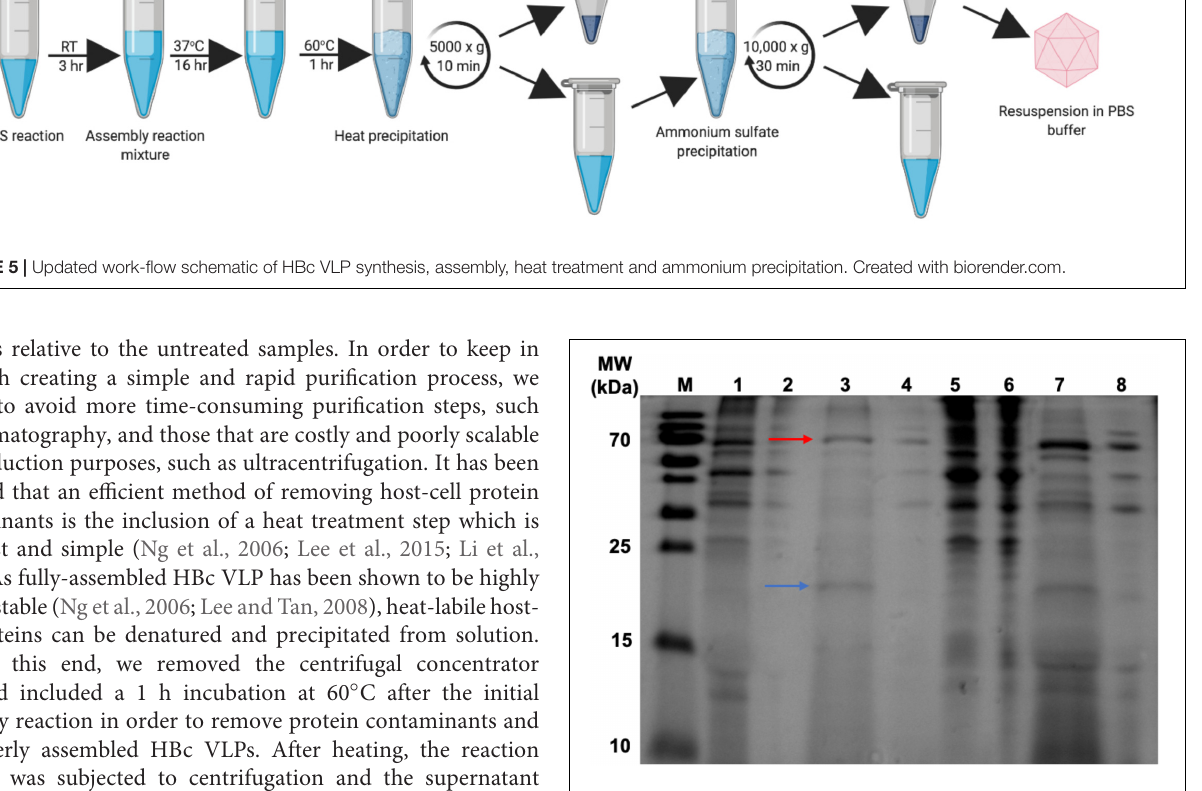
FIGURE 6 | SDS-PAGE gel displaying samples taken during heat-purification and ammonium sulfate precipitation post assembly reaction. Lanes 1–4 have undergone heat treatment then ammonium sulfate precipitation. Lanes 5–8 have undergone heat treatment only. Lane M, PageRuler pre-stained protein ladder; Lane 1, HBc (+CIP) supernatant after heat treatment and ammonium sulfate precipitation; Lane 2, Negative control (NC) (+CIP) supernatant after heat treatment and ammonium sulfate precipitation; Lane 3, HBc (+CIP) precipitate after heat treatment and ammonium sulfate precipitation; Lane 4, NC (+CIP) precipitate after heat treatment and ammonium sulfate precipitation; Lane 5, HBc (+CIP) precipitate after heat treatment only; Lane 6, NC (+CIP) after heat treatment only; Lane 7, HBc (+CIP) supernatant after heat treatment only; Lane 8, NC (+CIP) supernatant after heat treatment only. The blue arrow indicates the expected band size of the HBc monomer (21 kDa). The red arrow indicates the expected band size of the CIP protein (70